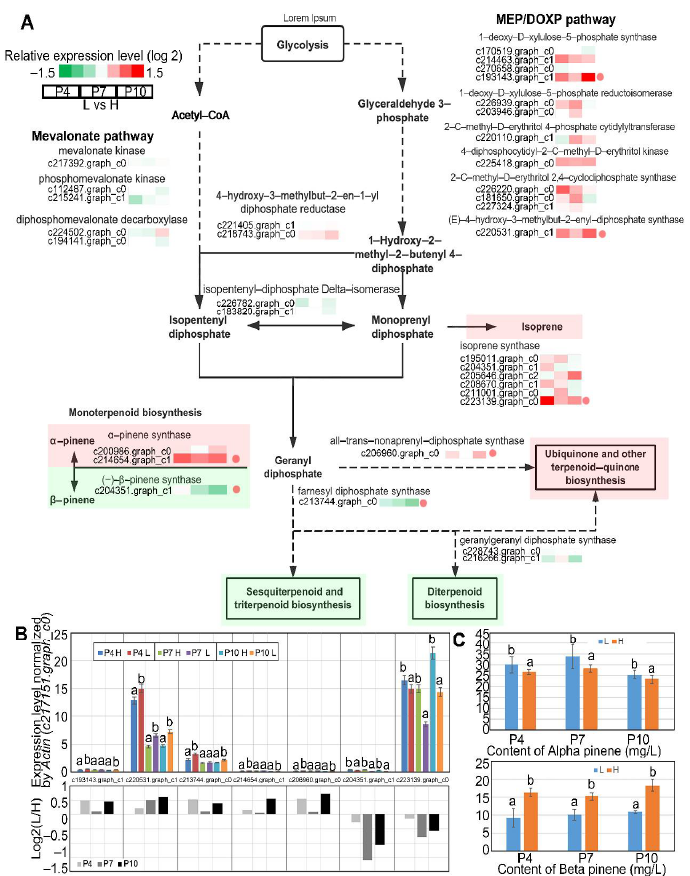
Figure 2. DEGs associated with the biosynthesis of terpenoids and steroids. ( A) Typical DEGs in the biosynthesis of terpenoids and steroids pathway. The boxes colored red and green represent upregulated and downregulated genes, respectively. H or L refer to high or low oleoresin-yielding slash pine. ( B ) Results of RT-PCR of 7 selected DEGs between high- and low-yielding slash. All exhibitions were standardized by the expression level of Actin ( c2171751.graph_c0 ). ( C ) The content of α - and β -pinenes in the vascular cambium of high- and low-yielding slash pines at P4, P7, and P10. All bars represent means ± s.d and those columns in histograms labeled with different letters are significantly different with p value < 0.05 by Duncan’s test. Four biological replications in the experiment were carried